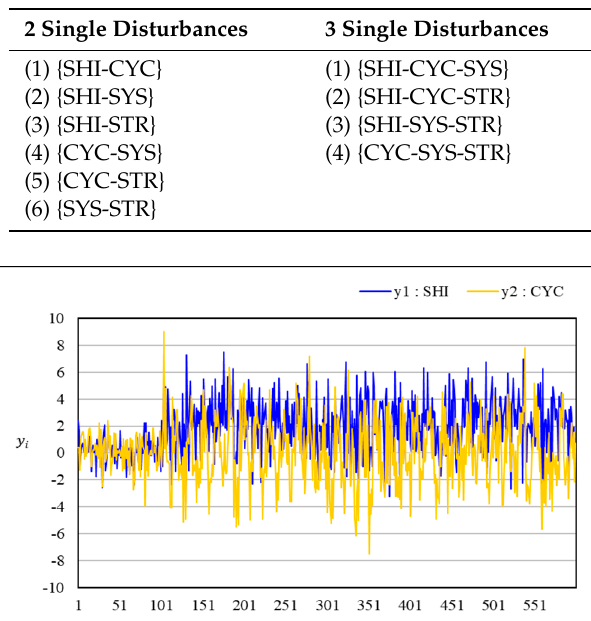
Table 1. Types of mixture control chart patterns (MCCPs) for two and three single disturbances in an MIMO process.